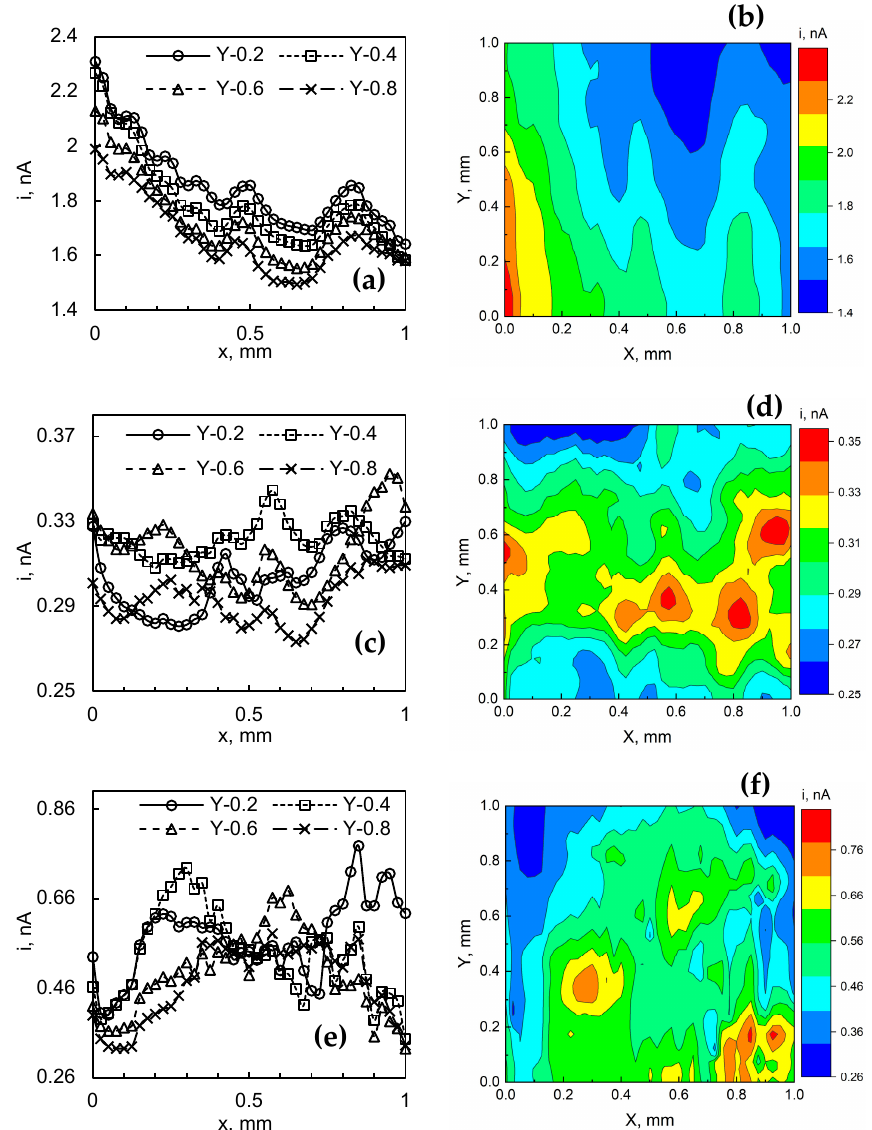
Figure 11. 2D profiles and 2D SECM maps: 2-min-WO 3 /MoS x ( a , b ); 5-min-WO 3 /MoS x ( c , d ); 30-min- WO 3 /MoS x ( e , f ) films, obtained in 0.5 M H 2 SO 4 . Probe scan speed 100 µ m s − 1 , data acquisition at 25 µ m intervals with a 25 µ m diameter probe.